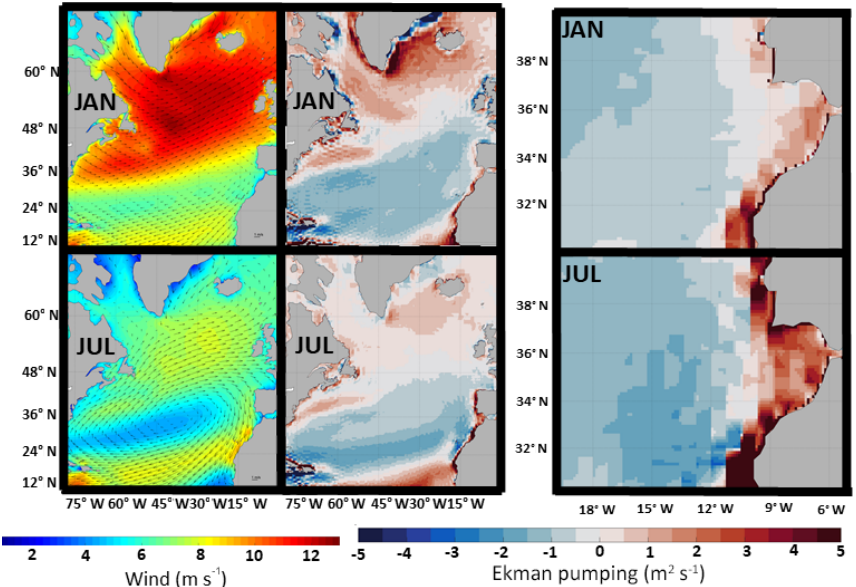
Figure 12. As Fig. 11 but for Ekman